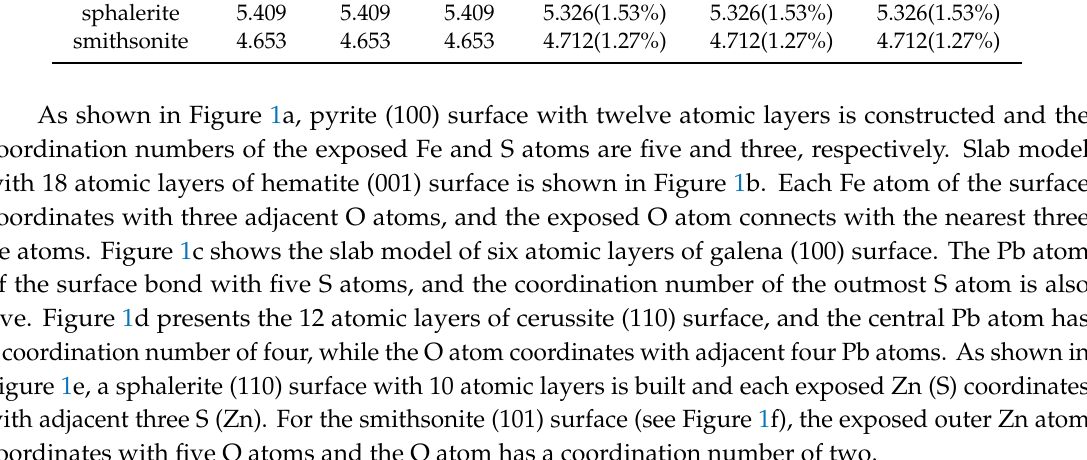
Table 1. The comparison between the lattice parameters of the optimized model and the experimental results of the bulk.